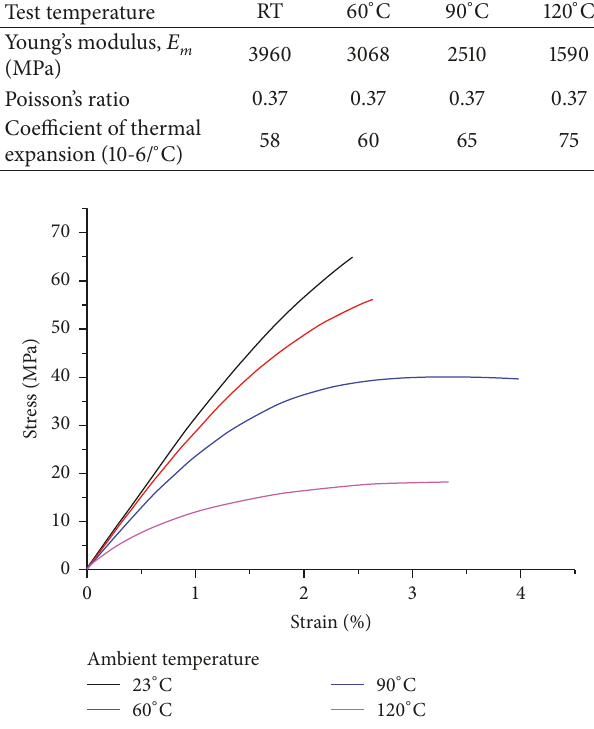
Figure 3: Representative stress-strain curves of the epoxy resin under different temperature